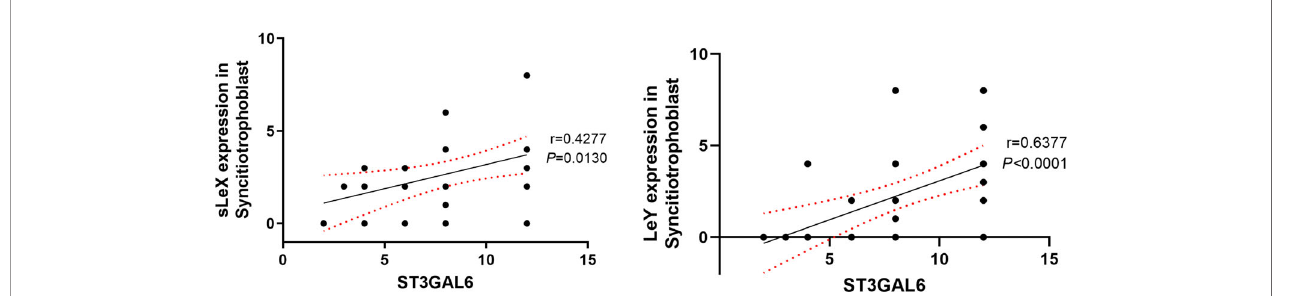
FIGURE 6 | Correlation of sLeX and LeY expression with ST3GAL6 in the syncitiotrophoblast. The IRS scores of sLeX and LeY staining were positively correlated with ST3GAL6 expression in the syncitiotrophoblast. Lines represent the Spearman ’ s rank correlation (black line) and 95% con fi dence interval (red dotted line).